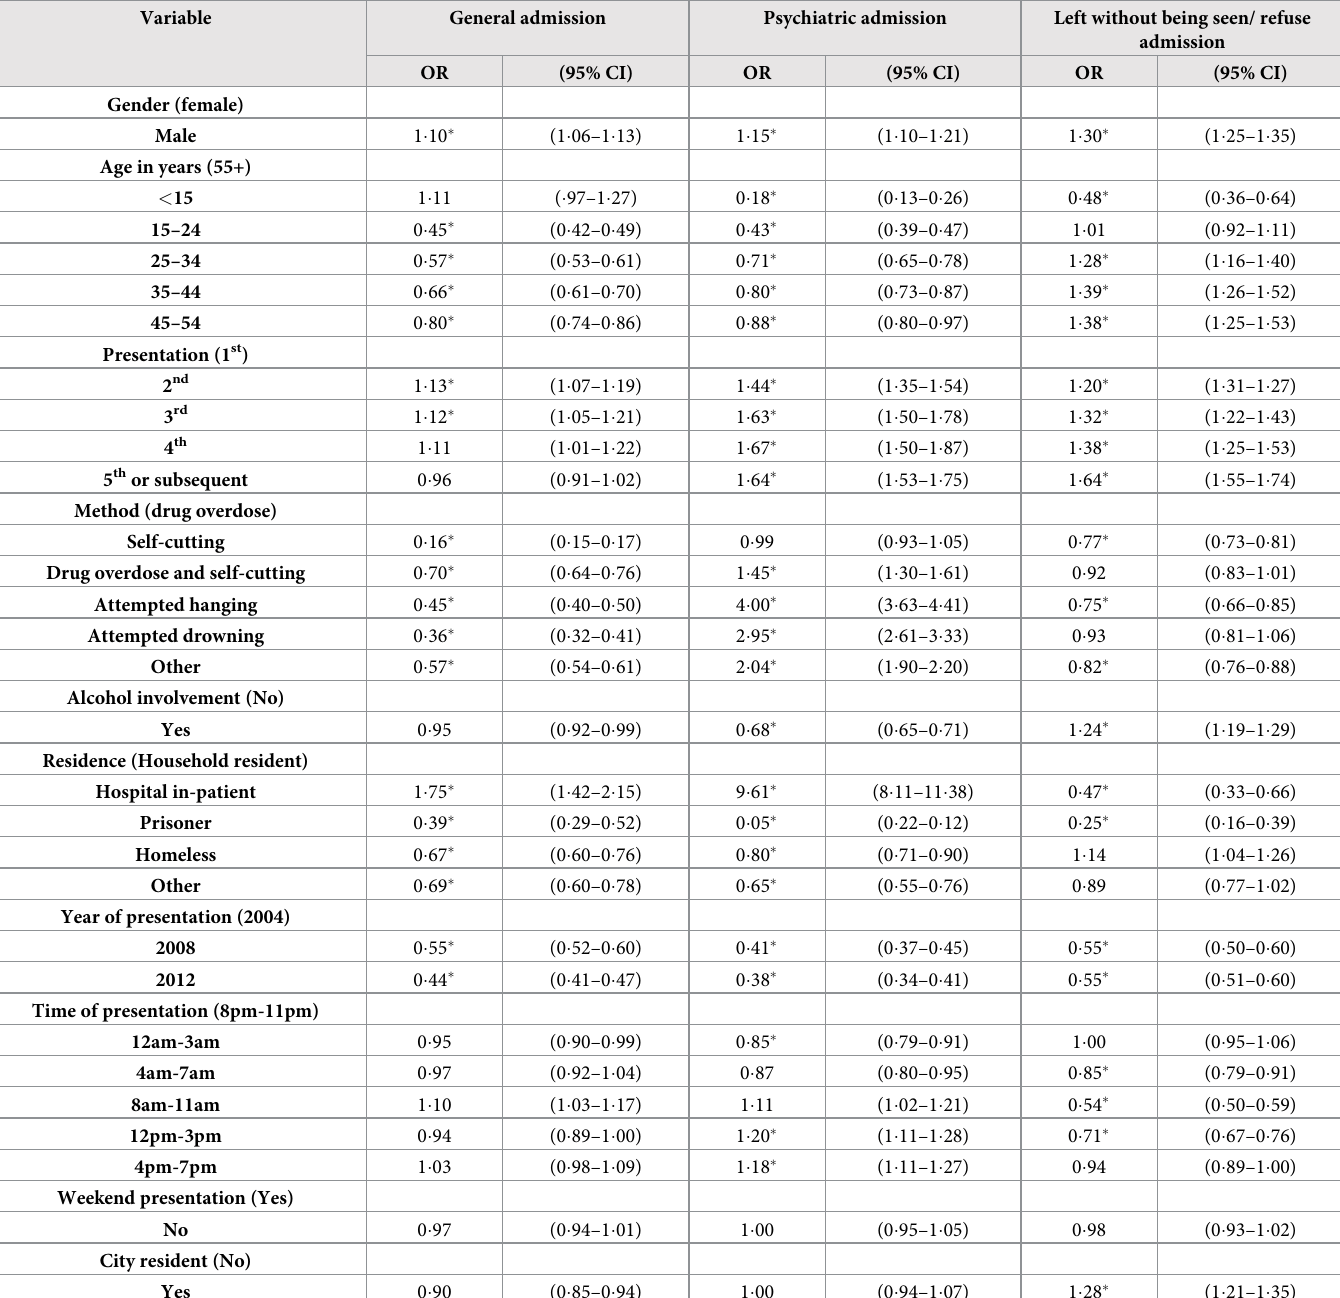
Table 2. Multinomial logistic regression analysis of the independent associations of factors and recommended next care following hospital-treated self-harm.